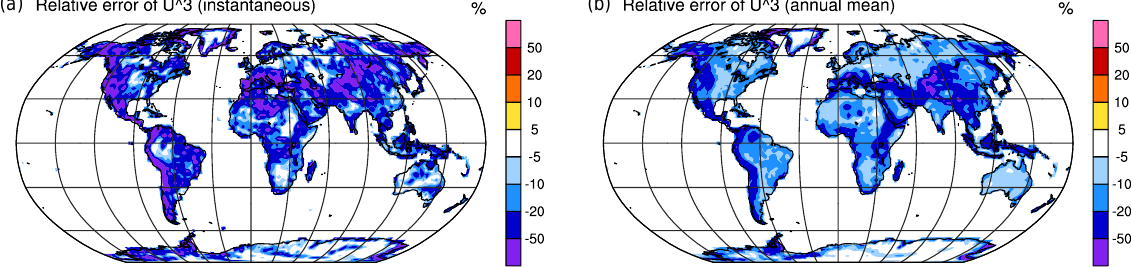
As in Fig. 3 but for the relative errors of U 3 10 over land. The errors are calculated for Eq. (12) assuming Eq. (13) is the “truth”.